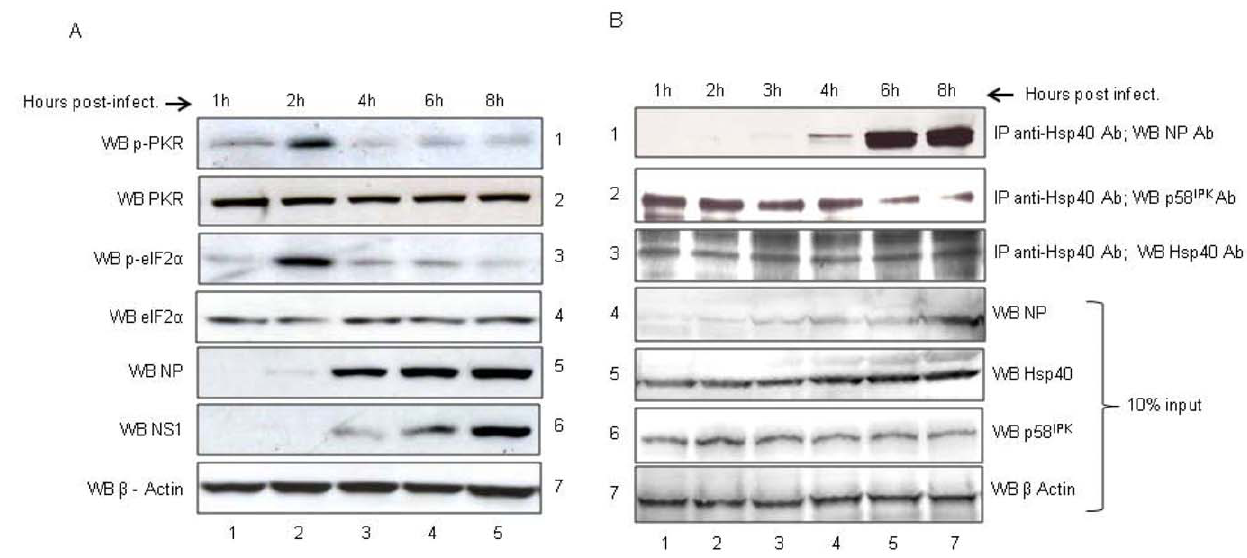
Figure 4. NP expression in IAV infected cells coincides with p-PKR and p-eIF2 a downregulation and P58 IPK -Hsp40 dissociation. A. A549 cells were infected with PR8 IAV at 1 MOI and cells were harvested at indicated time points post-infection. Western blotting was done to check the expression levels of PKR, p-PKR, eIF2 a , p-eIF2 a , NP and NS1. Panel 7 shows equal loading trough b -Actin control. This experiment was repeated thrice with similar results. B. A549 cells were infected with PR8 IAV at 1 MOI and cells were harvested at indicated time points. Protein concentration was measured by Bradford method and equal amount of protein sample from each time point was used to set up IP with anti-Hsp40 antibody. Panel 1 shows the amount of NP co-immunoprecipitated with Hsp40. Panel 2 shows amount of P58 IPK co-immunoprecipitated with Hsp40. Panel 3 shows amount of Hsp40 immunoprecipitated at different time points. Lanes 4, 5, and 6 show the levels of NP, Hsp40 and P58 IPK respectively, in cell lysates at the indicated time points as detected by western blotting using antibodies specific to NP, Hsp40 and P58 IPK . Panel 7 shows equal loading trough b -Actin control.